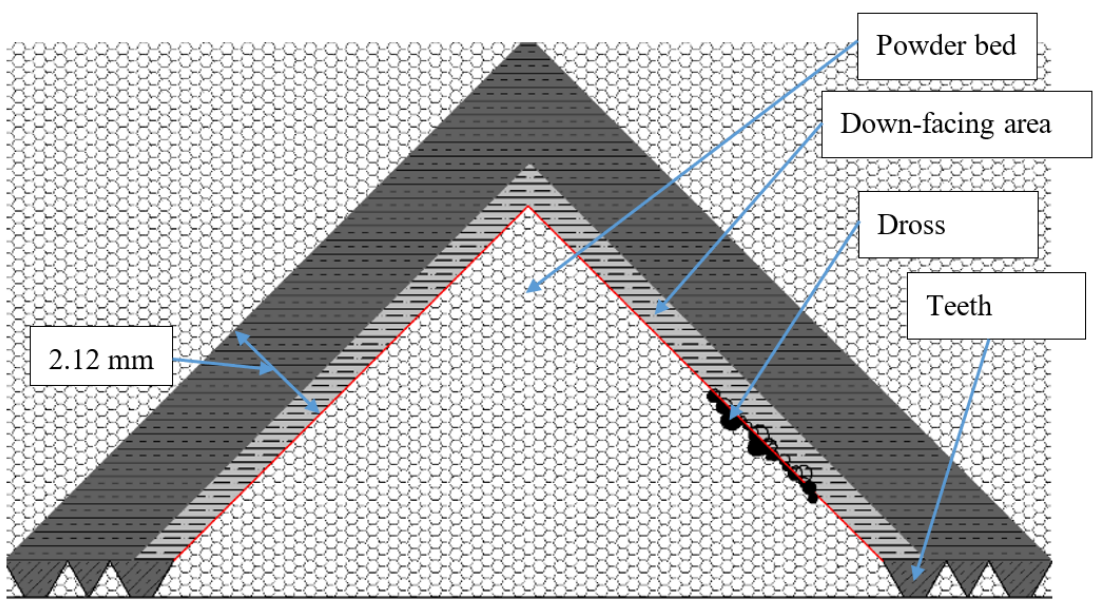
Figure 1. Depiction of dross formation on the down-facing surfaces of a part produced by laser-based powder bed fusion.